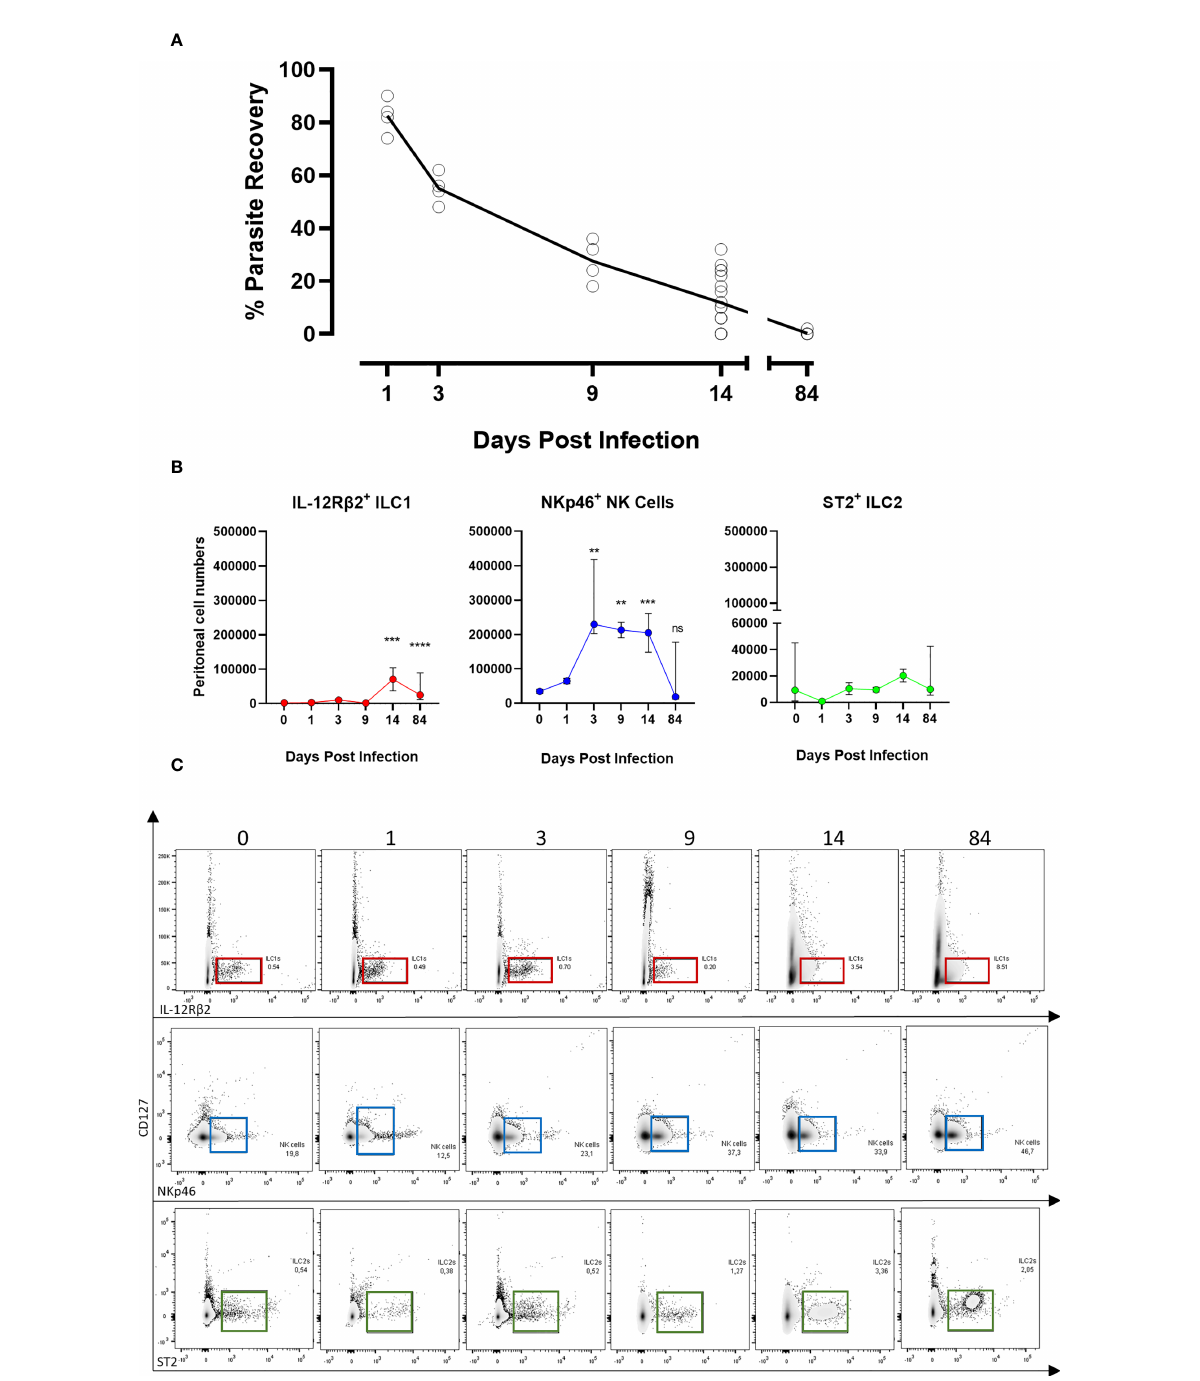
FIGURE 1 ILC populations dynamics at the site of Brugia malayi infection. (A) Parasite recovery in BALB/c infected mice over the time. (B) IL-12R b 2 + ILC1s (red), NKp46 + NK (blue) and ST2 + ILC2s (green) cell populations expansion in the peritoneal cavity of BALB/c immunocompetent mice following B. malayi infection. Kruskal-Wallis tests followed by Dunn ’ s multiple comparisons tests, n=4-25, pooled experiments. Signi fi cance is given as **: p < 0.01, ***:p < 0.001 and ****:p < 0.0001. ns, not signi fi cant. (C) Representative density plots and gating from lineage cocktail negative cells for IL-12R b 2 + ILC1s (red), NKp46 + NK cells (blue) and ST2 + ILC2s (green) using IL-12R b 2, NKp46 and ST2 respective pan markers between 0 and 84 days